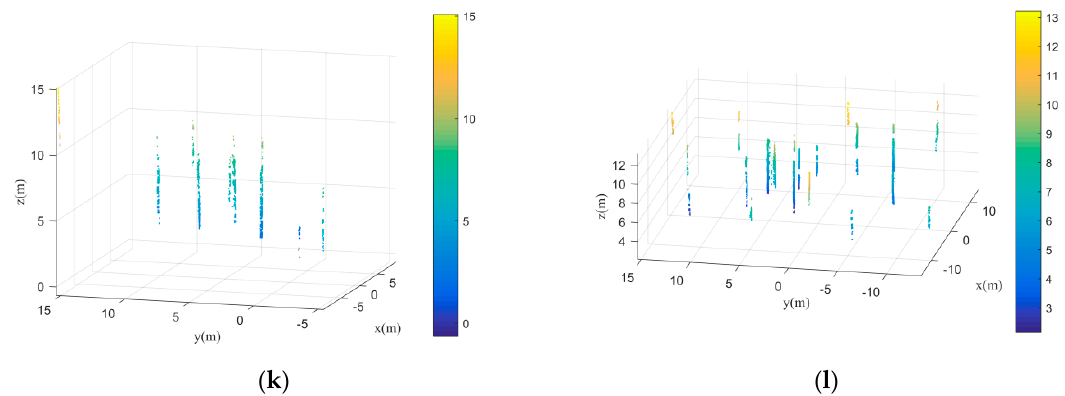
Figure 12. Extracted trunk stems for the six plots scanned in both single-scan and multi-scan modes. ( a , b ) are the extracted stems for Plot 1; ( c , d ) are the extracted stems for Plot 2; ( e , f ) are the extracted stems for Plot 3; ( g , h ) are the extracted stems for Plot 4; ( i , j ) are the extracted stems for Plot 5; ( k , l ) are the extracted stems for Plot 6; the first column represents the single-scan mode, while the second column represents the multi-scan